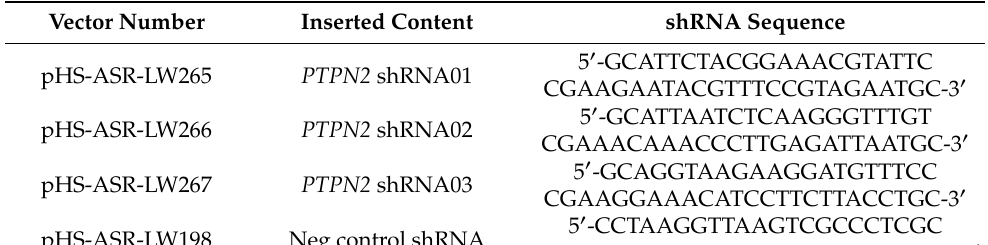
Table 3. Gene silencing lentivirus vector information.